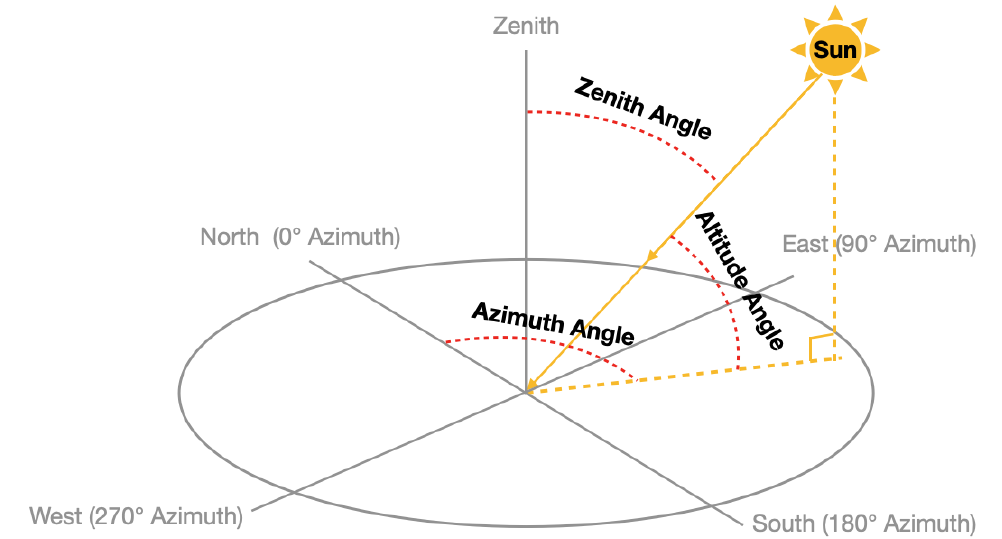
Figure 2. Schematic depicting the solar zenith angle, solar altitude angle and solar azimuth angle. Typically, a vertical profile through the atmosphere is split up into regions based on the temperature gradient with increasing height, e.g., the troposphere, stratosphere, mesosphere and thermosphere [17]. Significant absorption by ozone of the incoming sunlight occurs in the stratosphere (10–50 km). For typical levels of stratospheric ozone, this light absorption warms the stratosphere and prevents short wave UV at λ < 310 nm (which is harmful to life) from reaching the surface of the